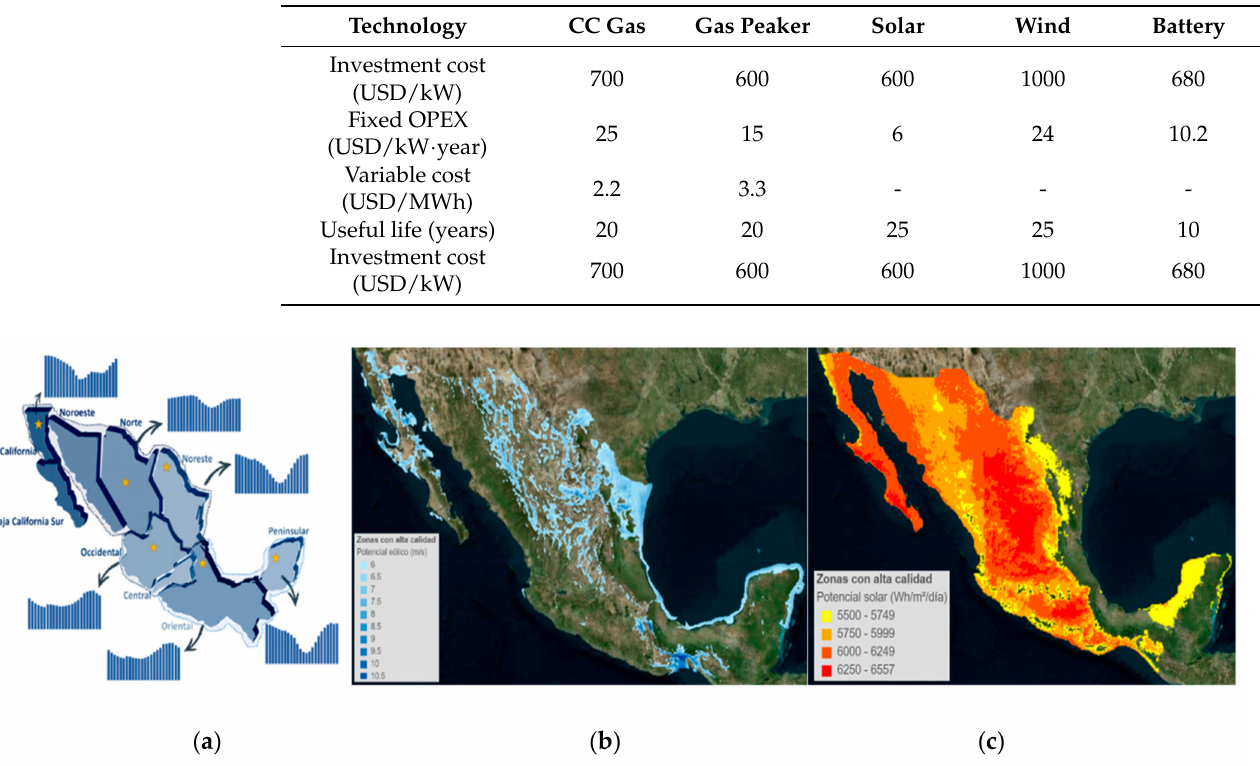
Table 2. Assumptions for expansion technologies in Mexico.